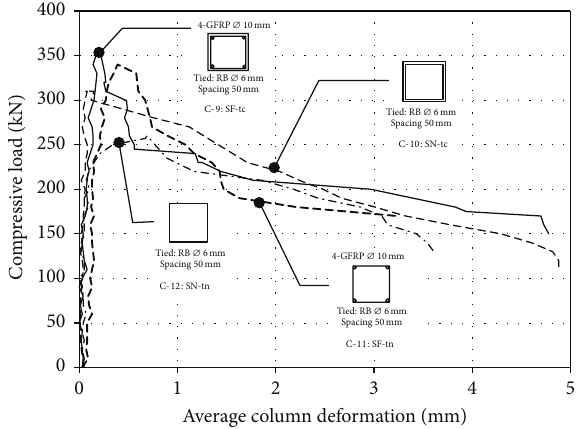
Figure 4: Load-deformation curves of rectangular specimens with ties.